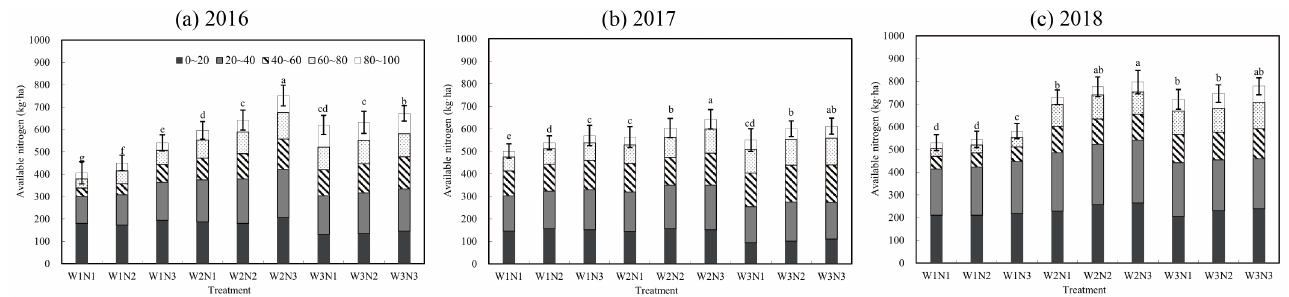
Figure 3. Soil alkaline hydrolysis nitrogen residue after harvest in 0–1 m soil layer. ( a ) 2016. ( b ) 2017. ( c ) 2018. Statistical comparisons were made by one-way ANOVA. Different characters mean signifi- cant differences found at p <